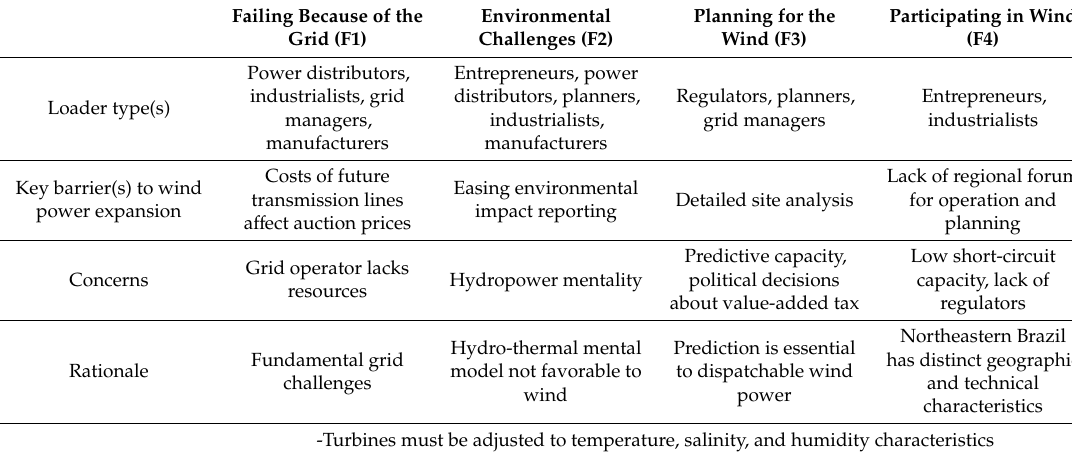
Table 5. Summary of four factors describing subjective views on barriers to wind power di ff usion in northeastern